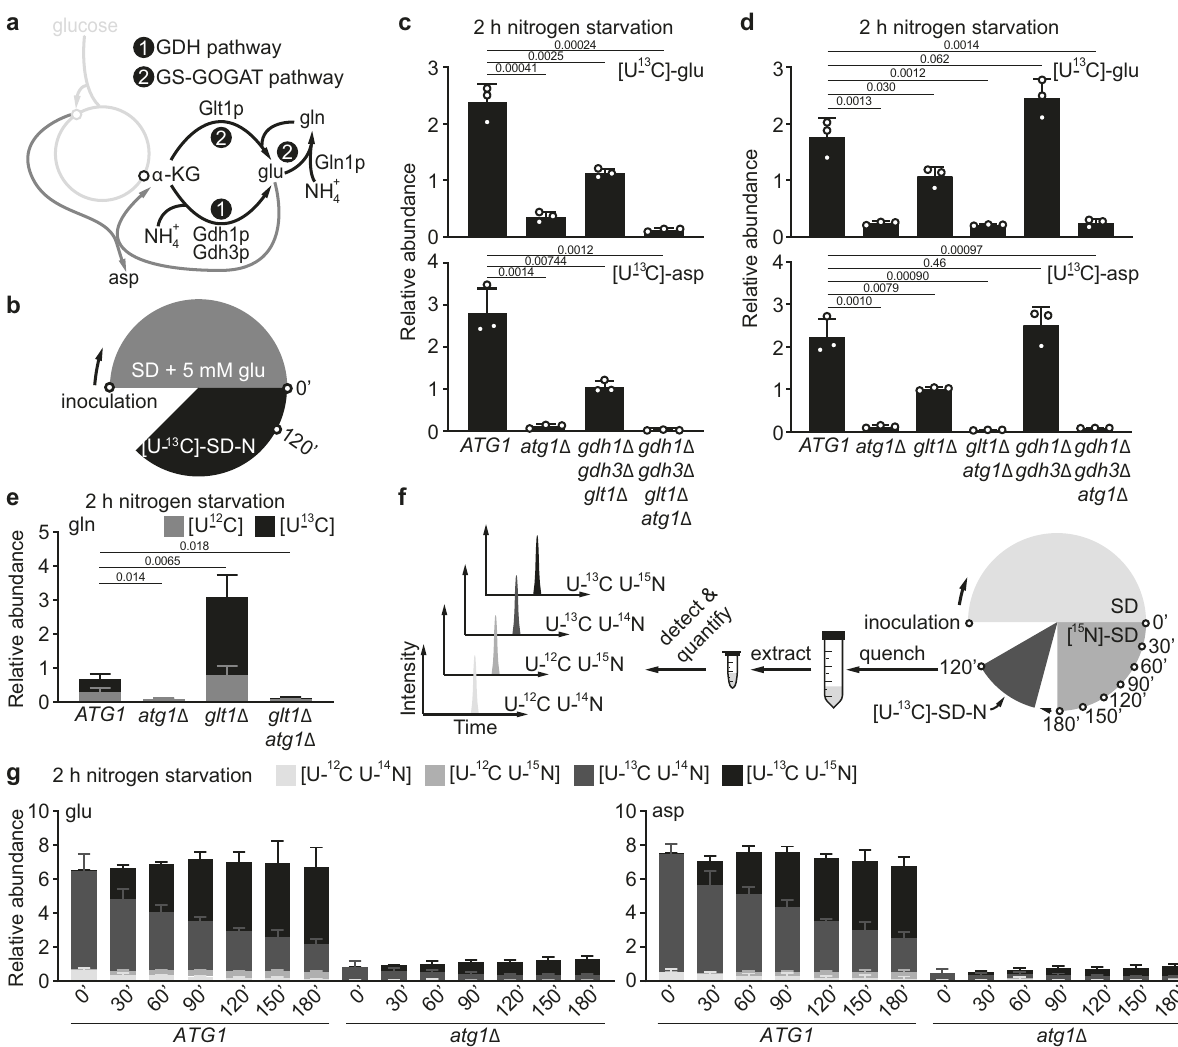
Fig. 5 The GS-GOGAT pathway assimilates ammonium to synthesize glutamate under nitrogen starvation. a Schematic of ammonium assimilation in S. cerevisiae . GDH: glutamate dehydrogenase (Gdh1p and Gdh3p); GS-GOGAT: glutamine synthetase (Gln1p)-glutamine oxoglutarate aminotransferase (Glt1p); α -KG: α -ketoglutarate. There are two major routes for glucose-derived carbon to enter the TCA cycle: acetyl-CoA to citrate (catalyzed by Cit1p and Cit3p) and pyruvate to oxaloacetate (catalyzed by Pyc1p and Pyc2p). b Schematic of the experimental design for c , d , and e . Cells were grown in glutamate- forti fi ed SD medium and shifted to [U- 13 C]-SD-N for 2 h. c Loss of ammonium assimilation impairs glutamate synthesis under nitrogen starvation. Three independent replicates. d Glutamate synthesis is impeded in glt1 Δ cells, but not in gdh1 Δ gdh3 Δ cells under nitrogen starvation. Three independent replicates. e The GS-GOGAT pathway predominantly assimilates ammonium to support glutamate synthesis under nitrogen starvation. Three independent replicates. f Schematic of experimental design for g . Cells grown in SD were labeled with 15 N for varying times and then starved in [U- 13 C]-SD-N for 2 h. g Autophagy degrades macromolecules (e.g., proteins) to provide nitrogen for glutamate and aspartate synthesis under nitrogen starvation. Three independent replicates. P values were calculated using unpaired two-sided Student ’ s t test assuming equal variances. Data are presented as mean ± standard